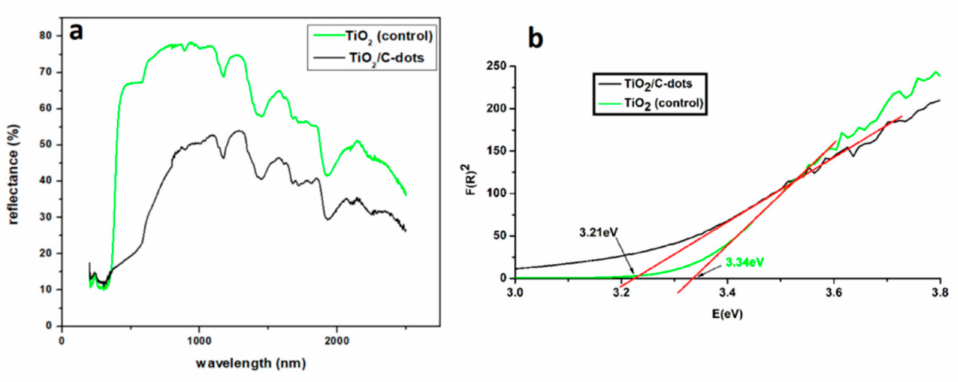
Figure 10. ( a ) Reflectance spectra and ( b ) Tauc plots of TiO 2 and TiO 2 enriched with C-dots for the calculation of their energy